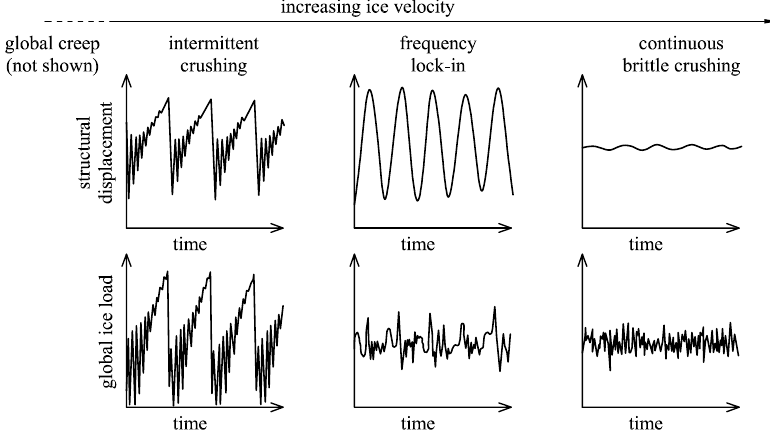
Figure 13. Illustrations of ice-load and structural-response patterns of vertical-sided structures in interaction with ice with varying speed. Adapted from ‘Dynamic response of an offshore structure interacting with an ice floe failing in crushing’ by Hendrikse, H. and Nord, T. S. (2019), Marine Structures, 130, p. 274. Copyright 2019, Elsevier